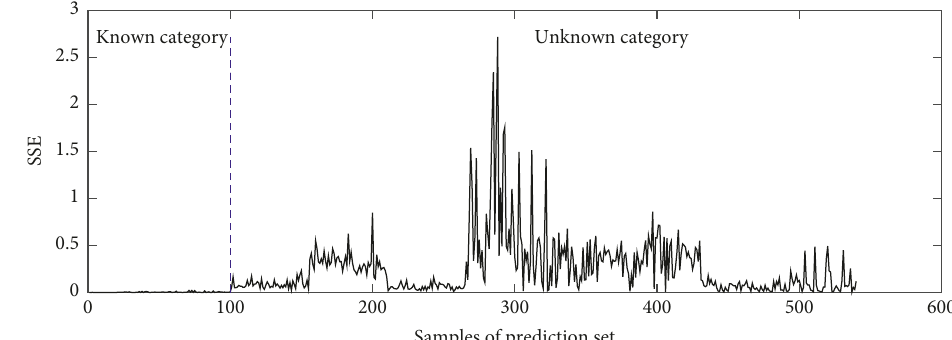
Figure 5: SSE comparison for the known category and unknown category.